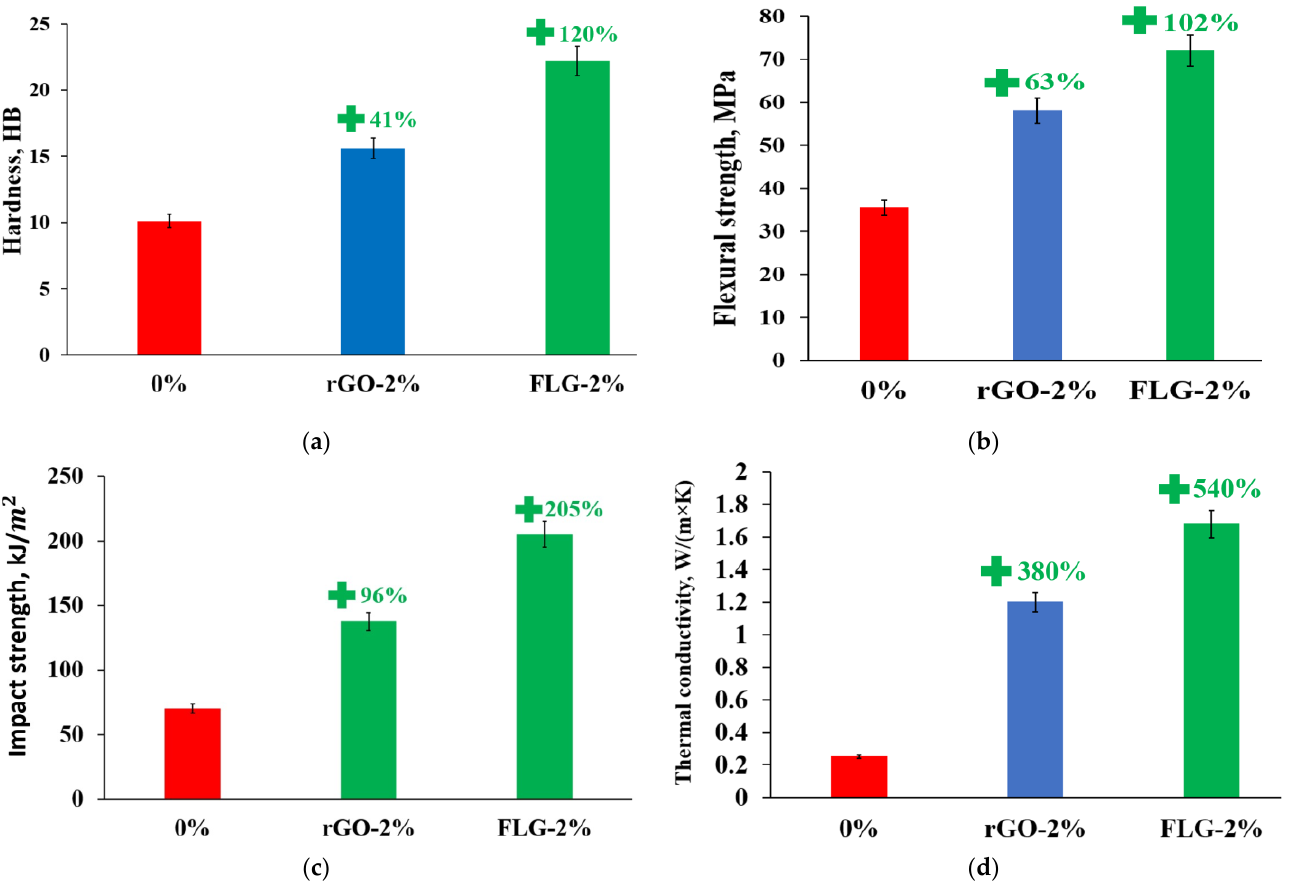
Figure 12. Comparison of the effectiveness of FLG and rGO: hardness ( a ), flexural strength ( b ), Charpy impact strength ( c ) and thermal conductivity ( d ).